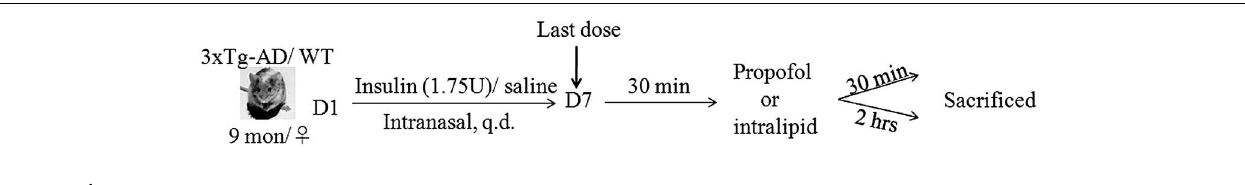
FIGURE 1 |Animal study